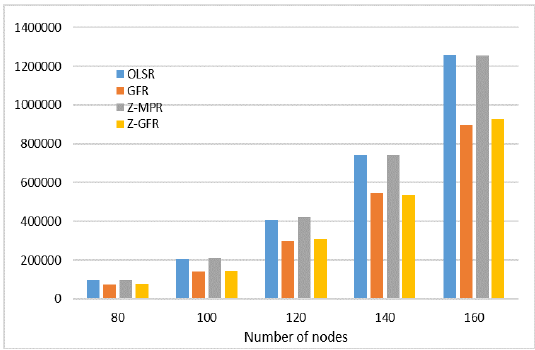
Figure 14. Number of receptions of TC messages.